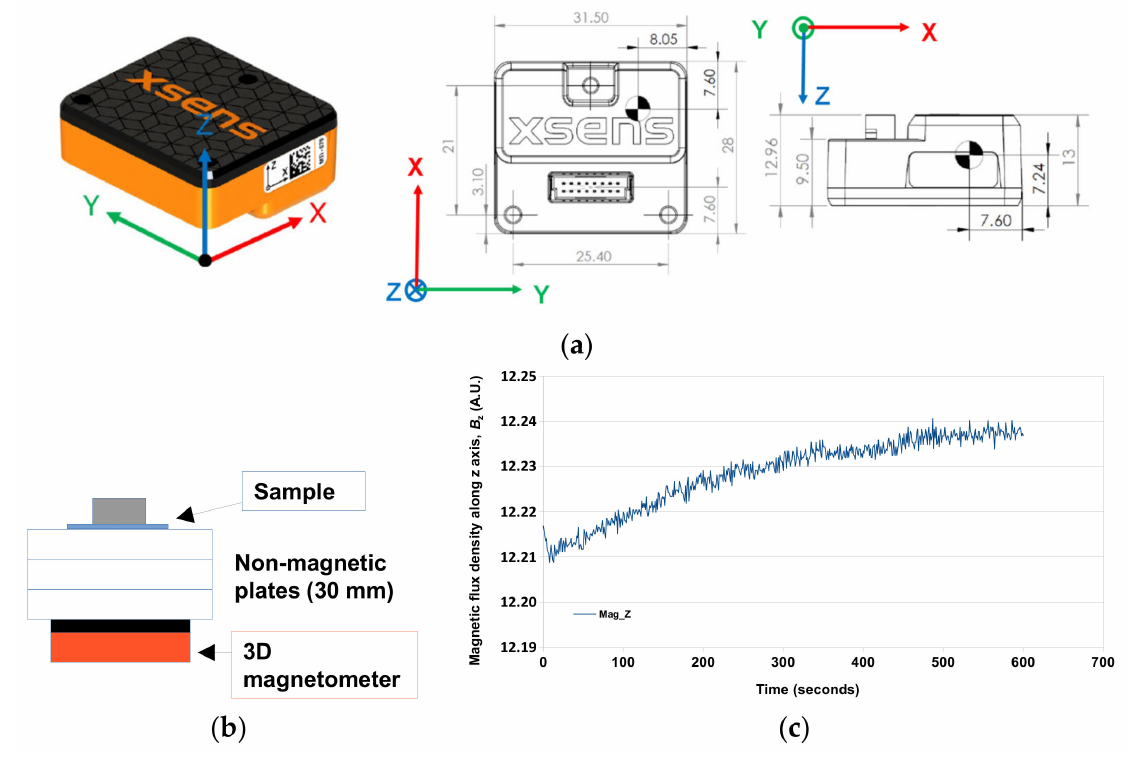
Figure 9. ( a ) Picture and details about the 3D magnetometer (reprinted from reference [28]), ( b ) schematic representation of the experimental setup used for the measurement of B z with the 3D-magnetometer, and ( c ) example of values of B z recorded during 10 min with the 3D-magnetometer from a reference magnetic